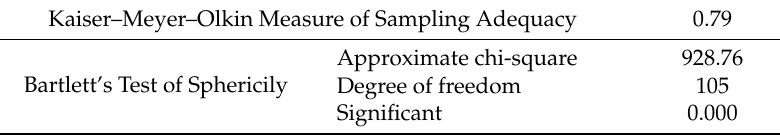
Table 3. Values of the Kaiser–Meyer–Olkin (KMO) test and Bartlett’s